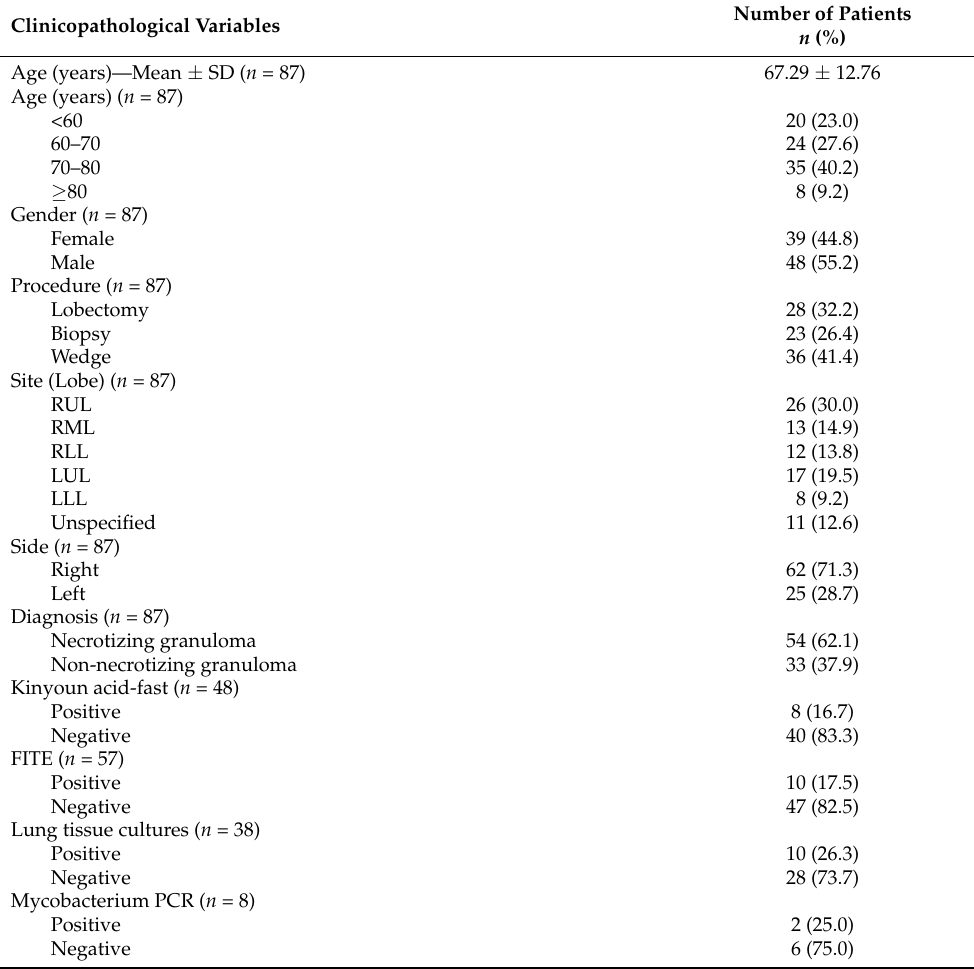
Table 1. Clinicopathological characteristics of patients with pulmonary granulomas (87 patients). Clinicopathological